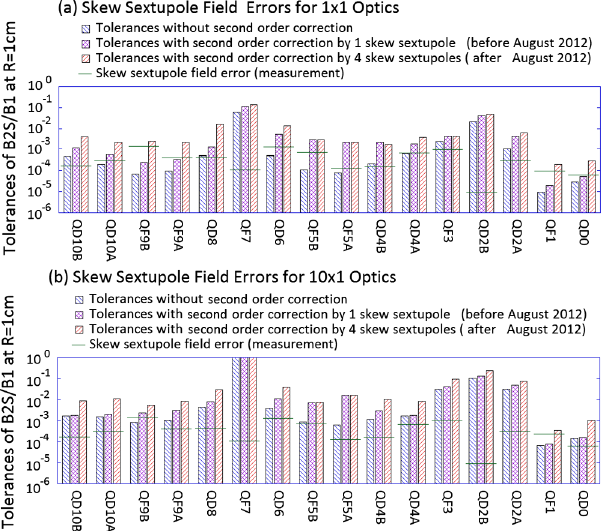
FIG. 13. Tolerance to skew sextupole field errors in ATF2 magnets for the (a) 1 × 1 optics and (b) 10 × 1 optics. The tolerances are defined by the requirement to induce a 2% beam size growth. Tolerances without second order knob correction, with correction by single skew sextupole, and with correction by four skew sextupoles are shown. Measured skew sextupole field errors are also shown.